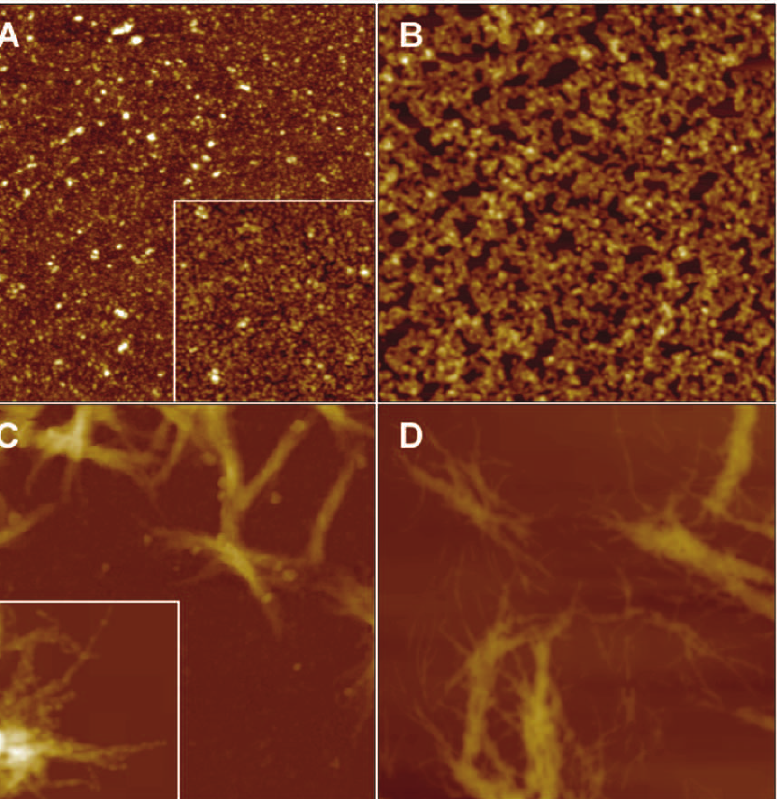
Figure 6. Tapping mode AFM images (height data) of the expanded variant AT3Q55 incubated at 37 6 C. The protein was incubated for: (A) 0 h (inset 2 h); (B) 24 h; (C) 48 h; (D) 72 h. The samples imaged in the inset of (C) and in (D) were treated with SDS (see Materials and Methods) to remove non fibrillar material. Scan size: (A, B, D) 2 m m; (C) 5 m m; insets 1 m m. Z range: (A) 10 nm, inset 20 nm; (B) 30 nm; (C) 700 nm, inset 180 nm; (D) 150